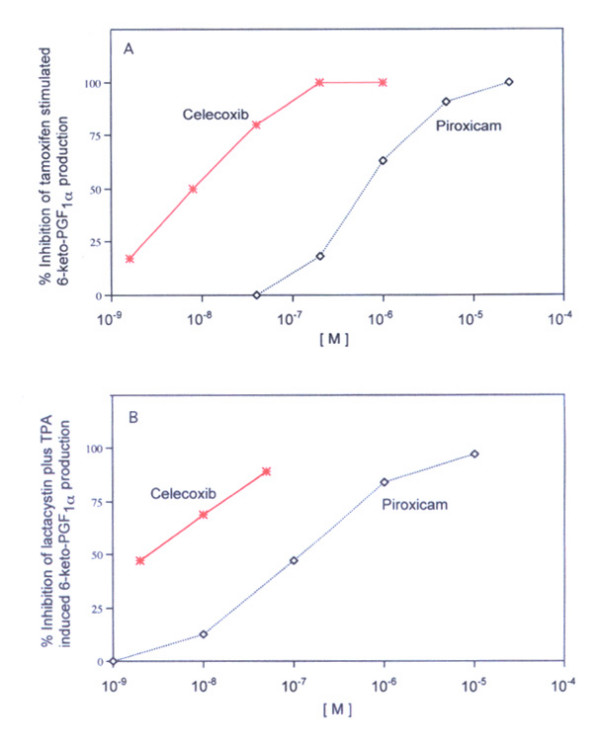
Inhibition of (A) tamoxifen (16 μM)-stimulated basal and (B) tamoxifen-stimulated induced 6-keto-PGF1α production (lactacystin in the presence of TPA) by celecoxib (*) and piroxicam (◊). Rat liver cells were incubated with either (A) tamoxifen (16 μM) or (B) lactacystin plus TPA in the presence of tamoxifen, for 6-h. The analyses were performed with triplicate dishes.